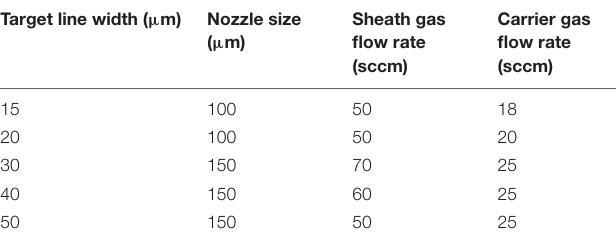
TABLE 2 | Aerosol jet printing (AJP) machine processing parameters used to achieve a range of PEDOT:PSS track widths on a glass